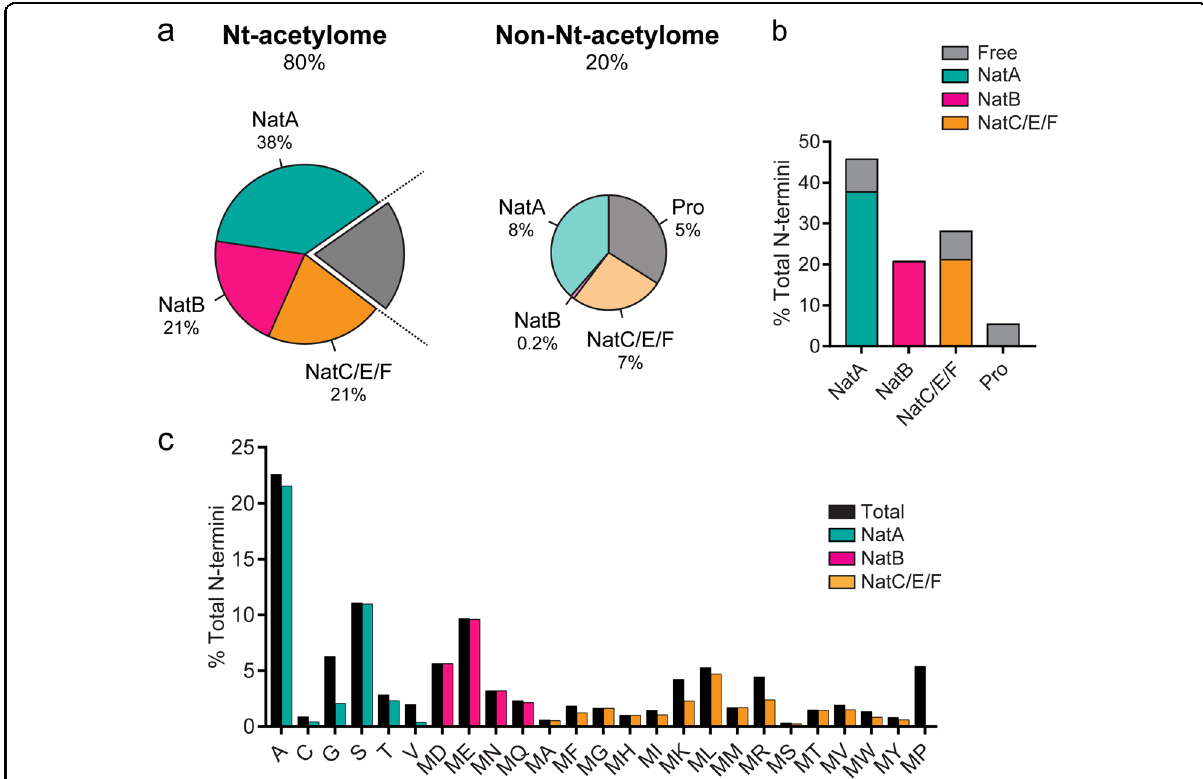
Fig. 2 Mapping the human Nt-acetylome. a The prevalence of Nt-acetylation in human cells is visualized by separating the proteome into the Nt- acetylome (80%) and the non-Nt-acetylome (20%). The human Nt-acetylome was predicted by incorporating experimentally determined Nt- acetylation events (including NatC- 47 and NatF- 56 related data) to all SwissProt entries (version 57.8) based on the occurrence of the fi rst two amino acids. Note that this global estimate does not consider the distinction between full and partial Nt-acetylation. Thus, a given protein can exist in both Nt-acetylated and non-Nt-acetylated forms. The chance that your favorite protein will be Nt-acetylated mainly depends on the identity of the fi rst two amino acids. To visualize this concept, the Nt-acetylome can be grouped according to b NAT substrate class and/or c N-terminal amino acid frequency. For example, NatB-type substrates (MD-, ME-, MN- MQ-) are almost fully Nt-acetylated and account for 21% of the proteome. The combined NatC/E/F substrate class needs further re fi nement, which is re fl ected by a coverage rate of 75%. For example, an estimated 89% of ML- starting N-termini are Nt-acetylated, which is in stark contrast to MK- starting N-termini, where only 54% of N-termini are thought to be Nt-acetylated. MW- and MR- data are inferred based on structural similarity to MF- and MK-, respectively. NatD is not depicted due to its limited